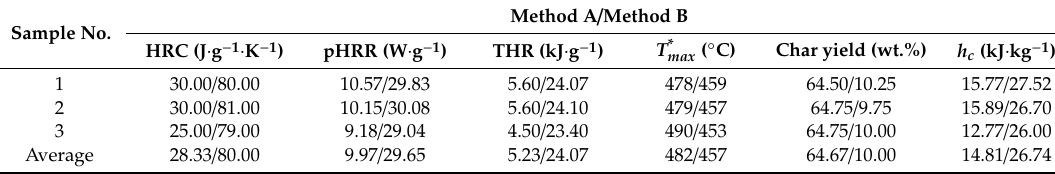
Table 5. PCFC parameters for the IM layer.